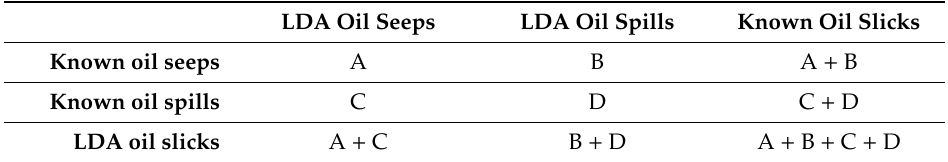
Table 1. Confusion matrix [73,74]. In our current research, our linear discriminant analyses (LDAs) explore a condensed two-by-two table format—refer to Table